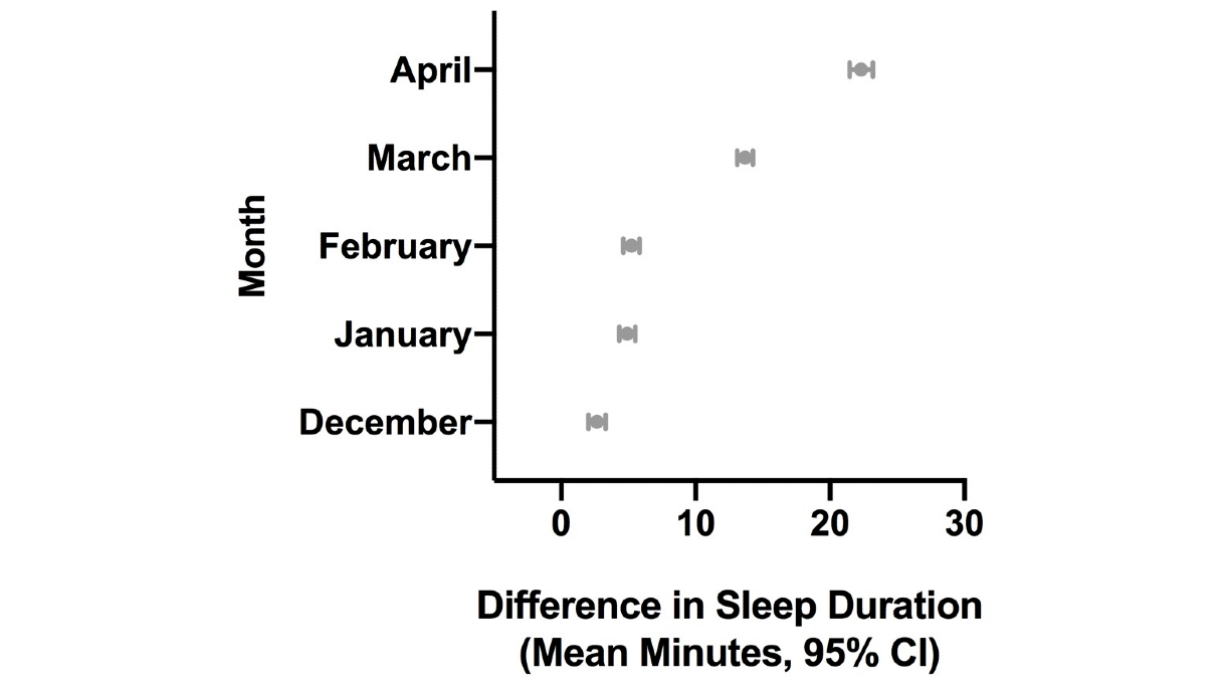
Figure 3. Difference in estimated sleep duration during the COVID-19 pandemic compared to the same month in the previous year in the total sample.